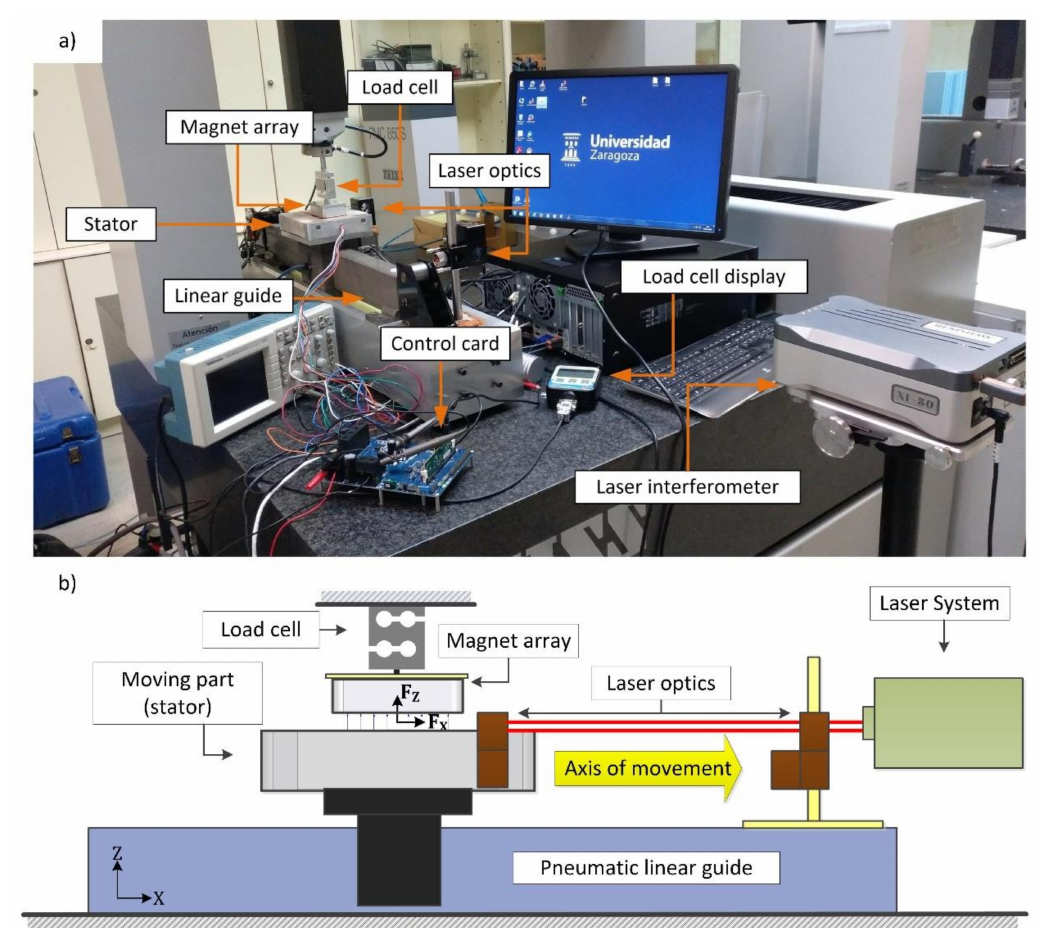
Figure 4. Experimental setup overview ( a ) and scheme ( b